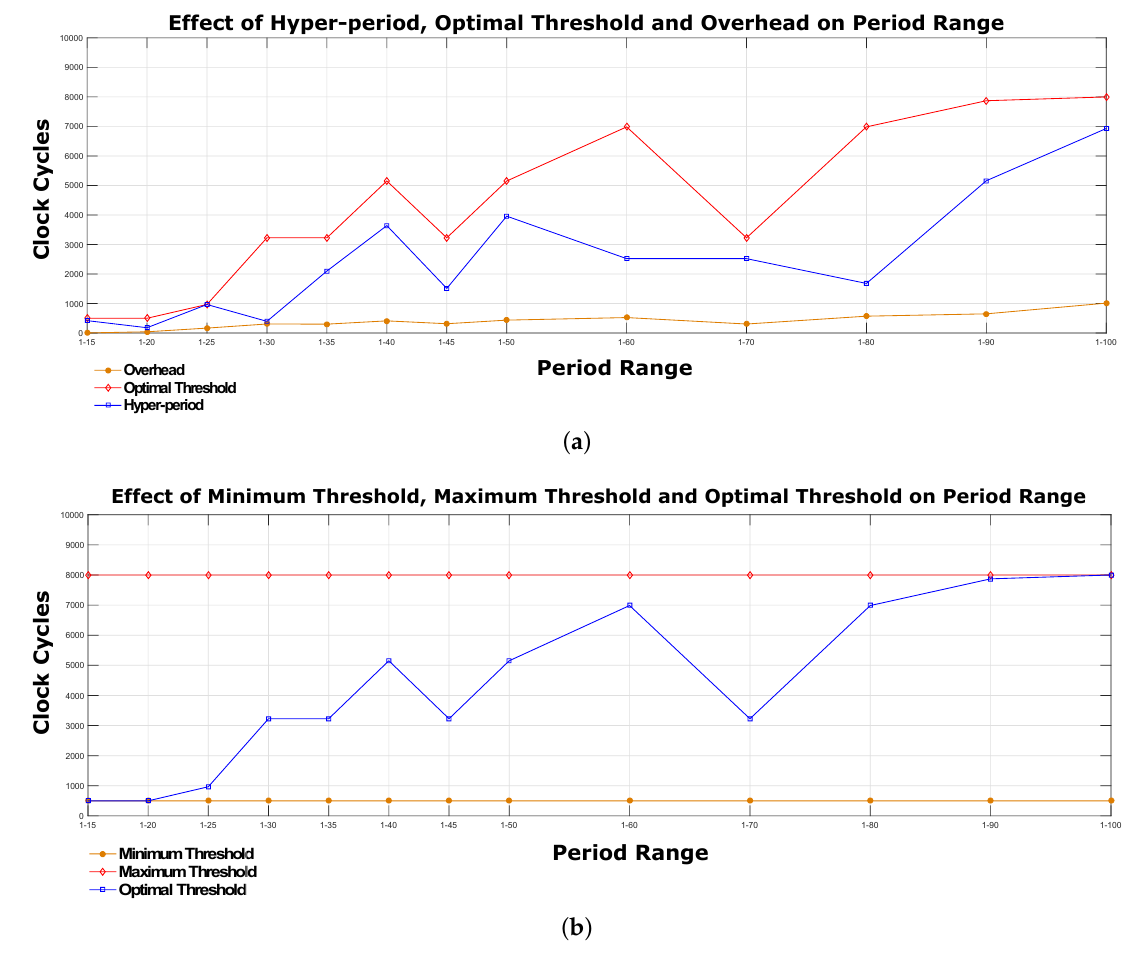
Figure 8. Scenario 2: The effect of varying Period Range, given No. of Tasks = 1–10, Execution Time Range = 1–5, Arrival Time Range = 1–5. ( a ) effect of hyper-period, optimal threshold and overhead on period range; ( b ) effect of optimal threshold on period